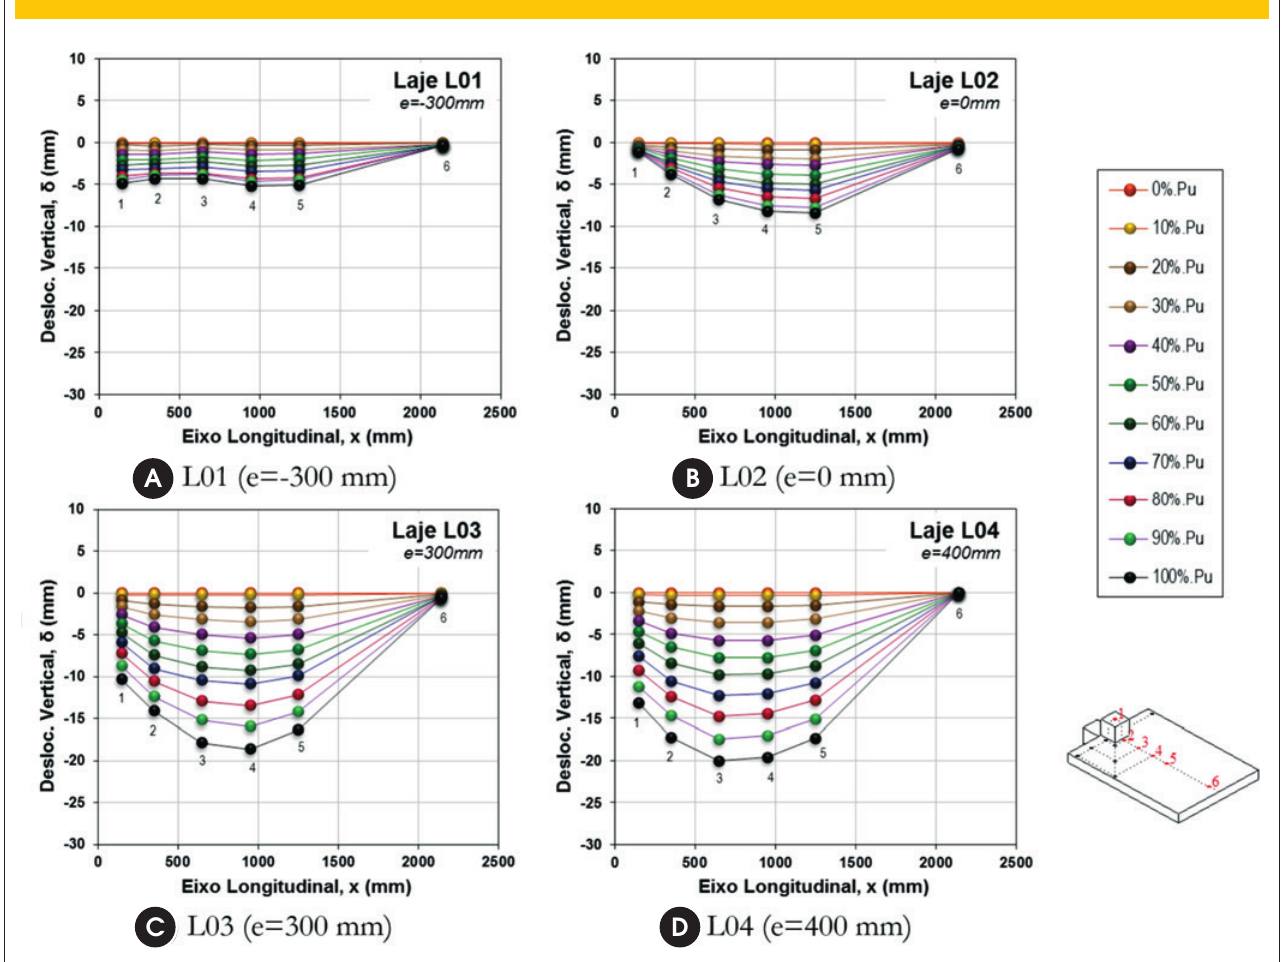
Figure 15 – Vertical displacements along the longitudinal axis of the